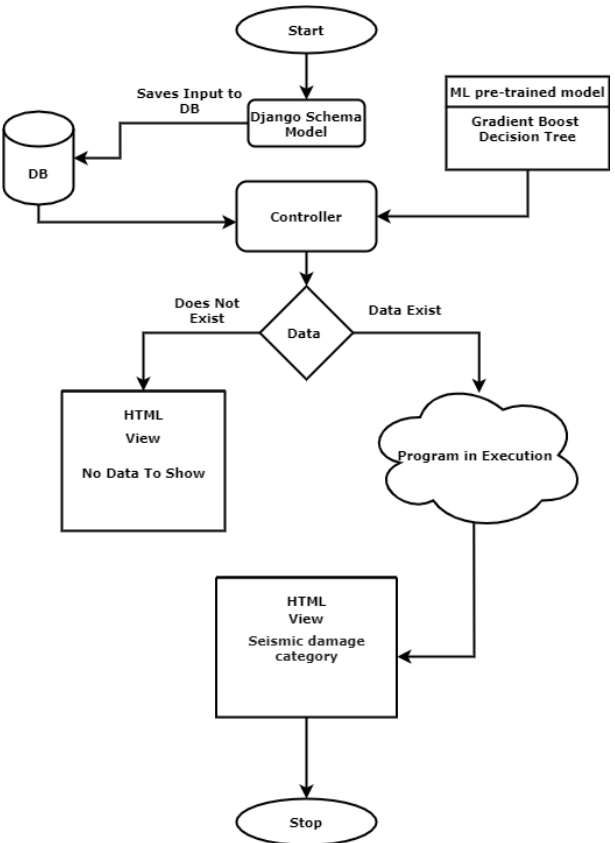
Figure 10. The flow of the web application based on the Django